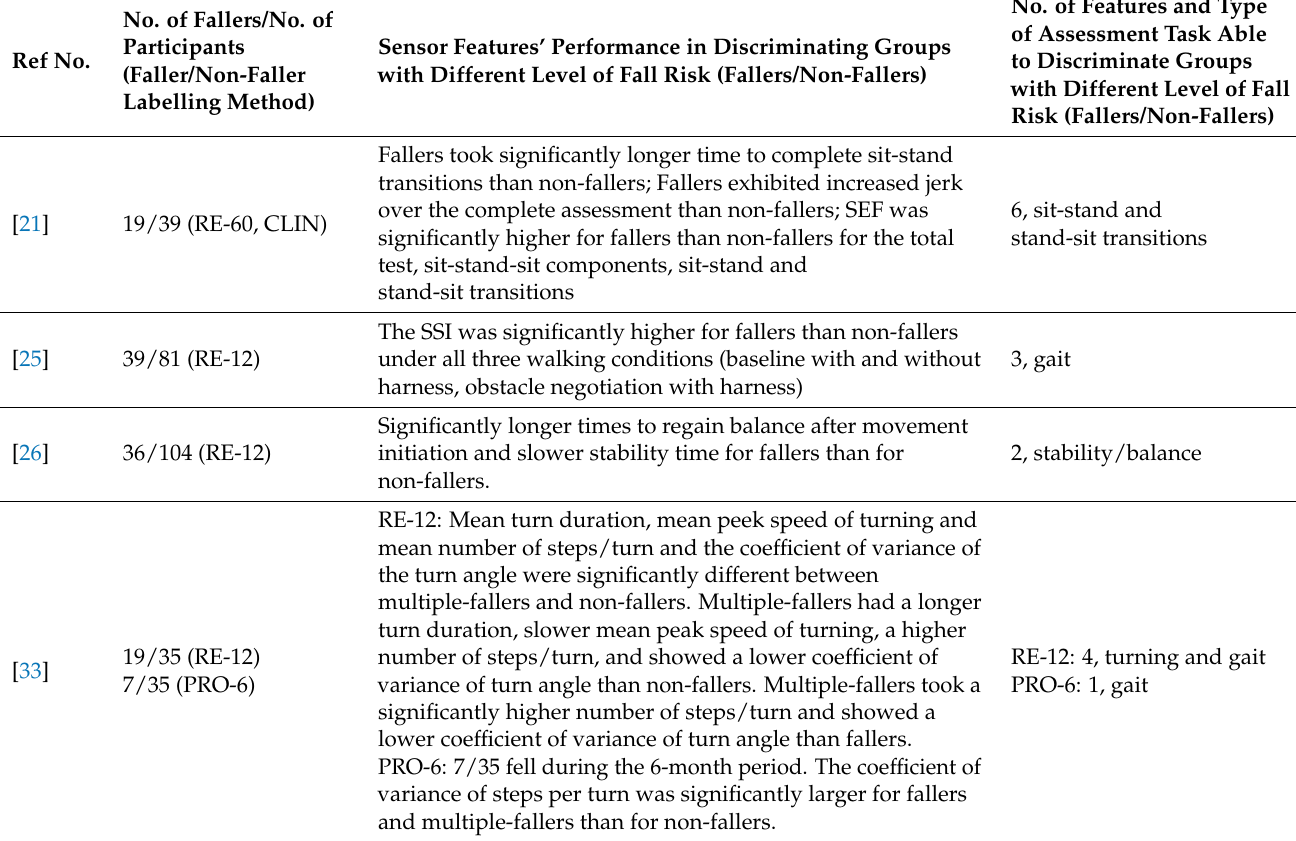
Table 7. Statistical analyses on the sensor-based features’ abilities to discriminate groups with distinct levels of fall risk. BMI = Body Mass Index. No. of Fallers/No. Ref No.